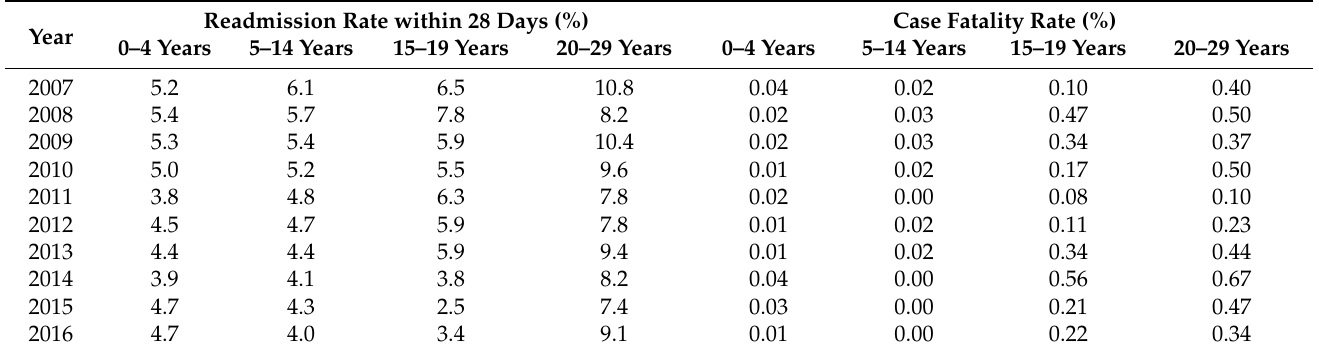
Table 2. Readmission rate within 28 days and case fatality rate of asthma patients by sex and age group